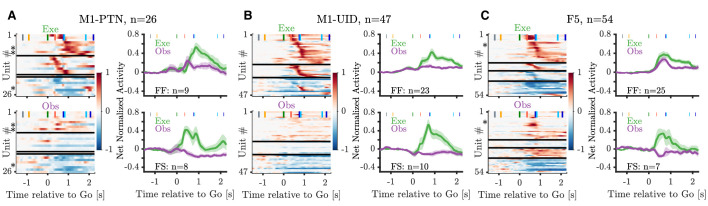
WHG Heatmaps and population averages.Heatmaps and population averages for MN sub-categories and populations during WHG. All plotting conventions as in Figure 5.